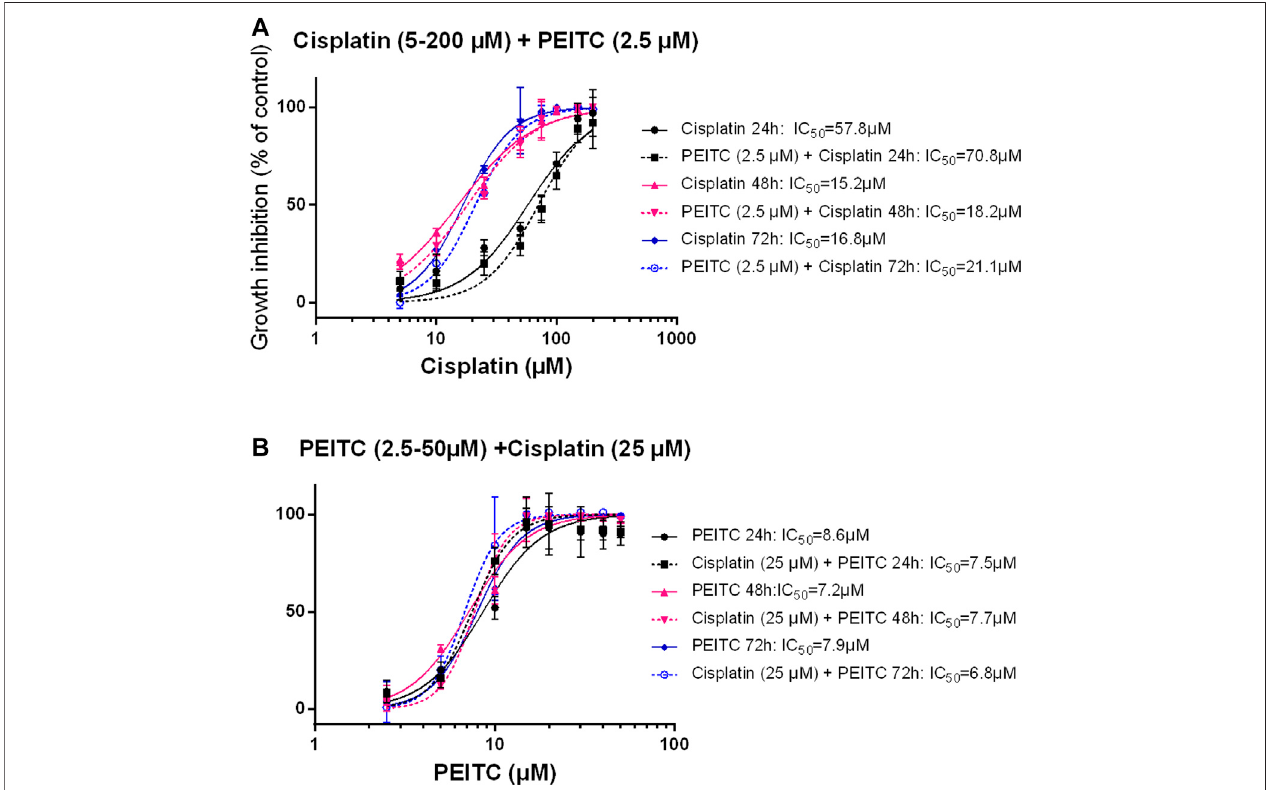
FIGURE 6 | Simultaneous treatment with PEITC and Cisplatin as different concentrations of cisplatin (A) and different concentrations of PEITC (B) . Mean ± SD. PEITC, phenethyl isothiocyanate.